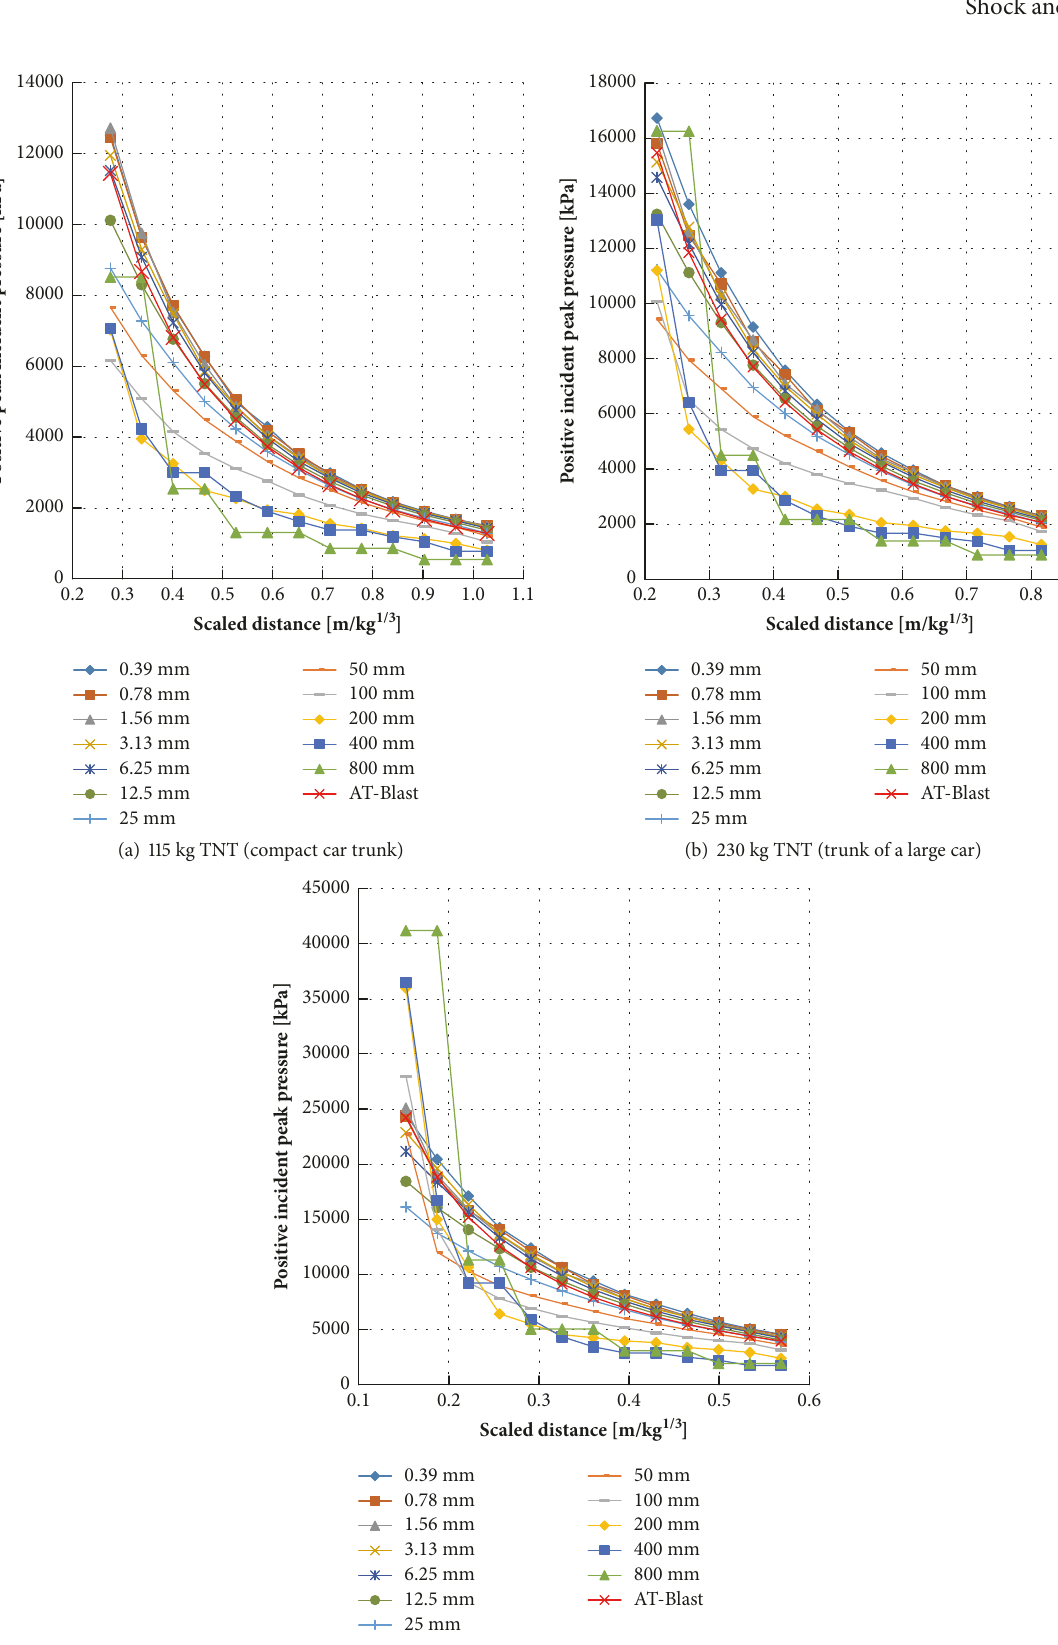
Figure 5: Variation of positive incident peak pressure with scaled